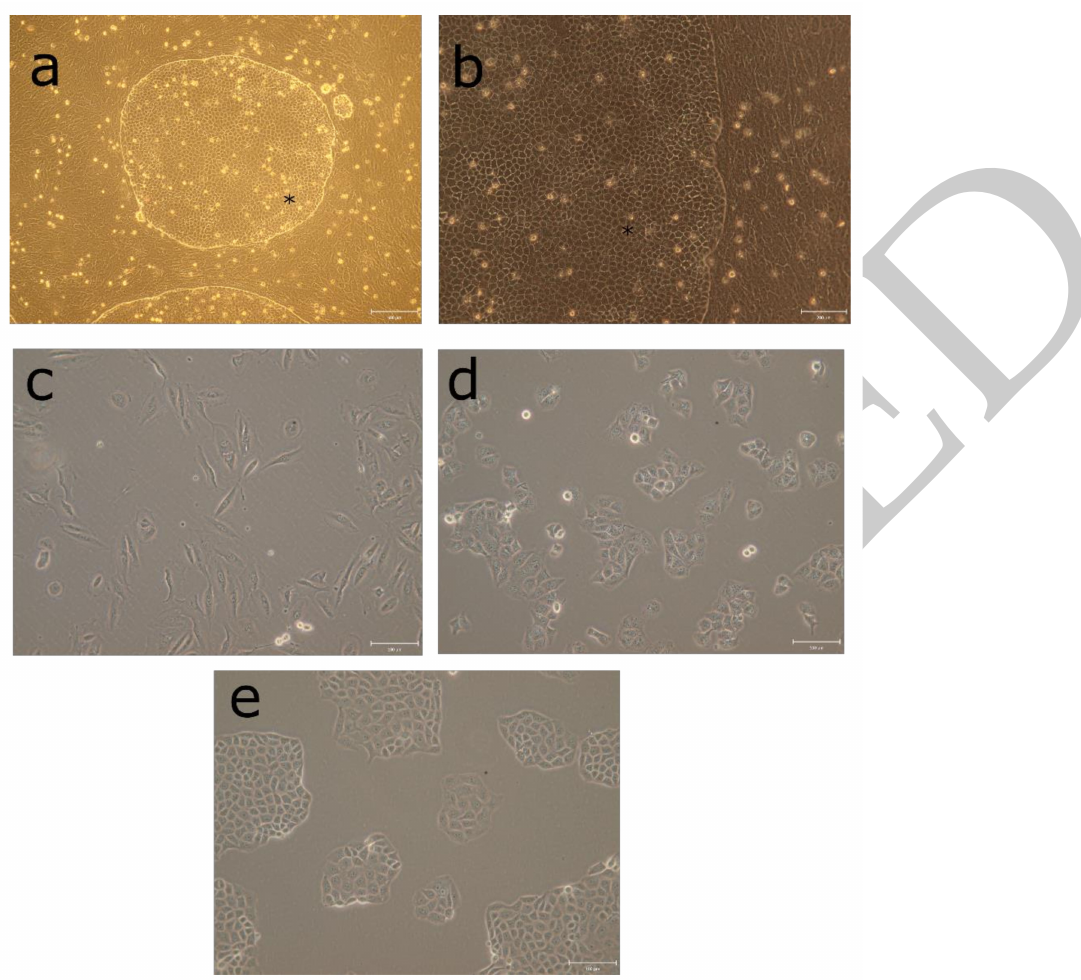
Figure 1. ARPE19 derived LEPI cells with cobblestone morphology arose from regular ARPE19 cultures. The round cell colonies containing the LEPI cell population (marked with *) inside the ARPE19 cultures showed distinct morphology compared to regular ARPE19 cells ( a , b ). At low culture densities, the regular ARPE19 cells ( c ) display more spindle shape morphology compared to LEPI cells ( d ) that instantly displayed cuboidal epithelial-like phenotype at 24 h after sub-culturing. The cells start to display RPE-like morphology 3 days after sub-culturing at 1:30 density ( e ). Scale bars ( a ) 500 µ